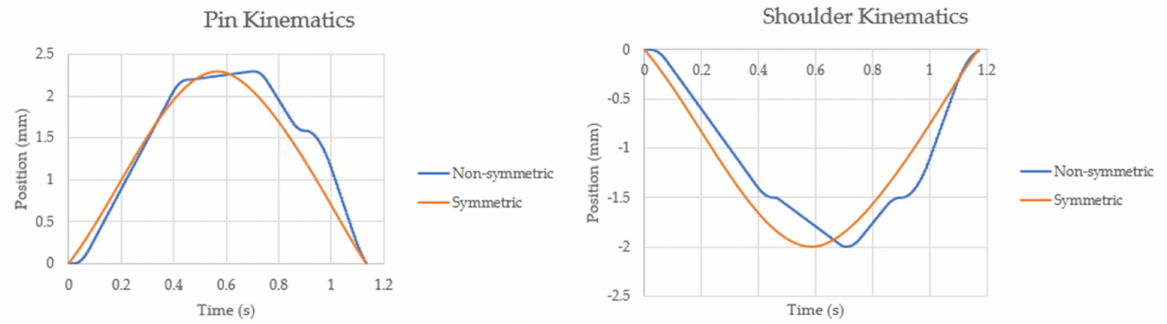
Figure 4. Visualization of the kinematics for the tooling in the welding process. Kinematics of the pin. Kinematics of the